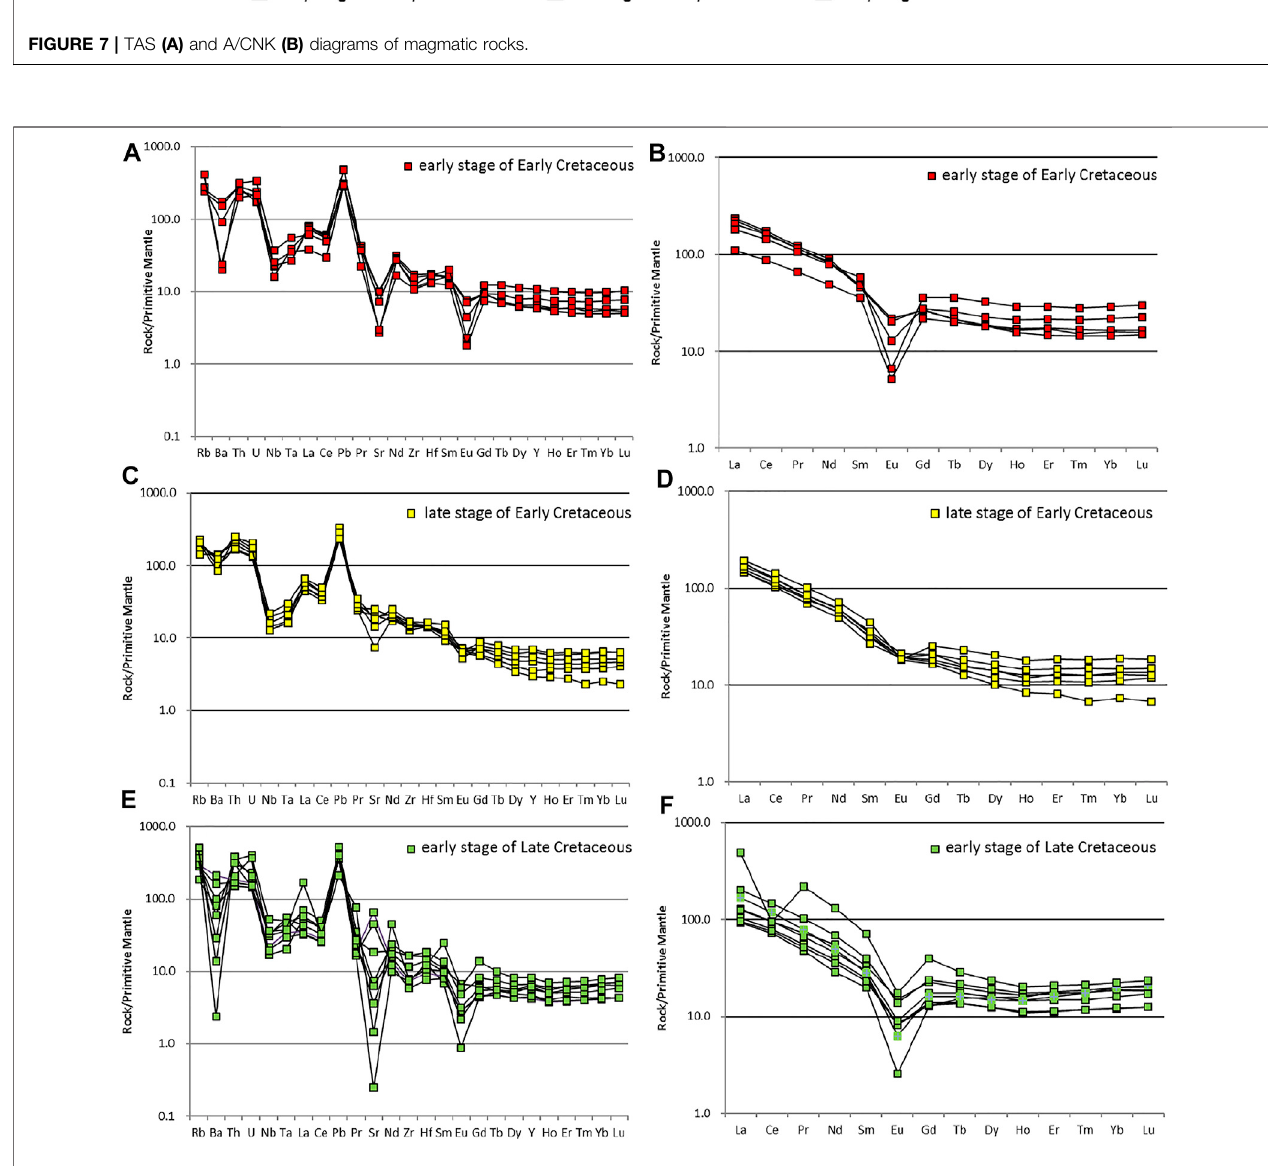
FIGURE8| ChondriteNormalizedREEdistributionpatterns (A),(C),(E) andprimitivemantlenormalizedtraceelementspiderdiagram (B),(D),(F) ofgraniticrocks.